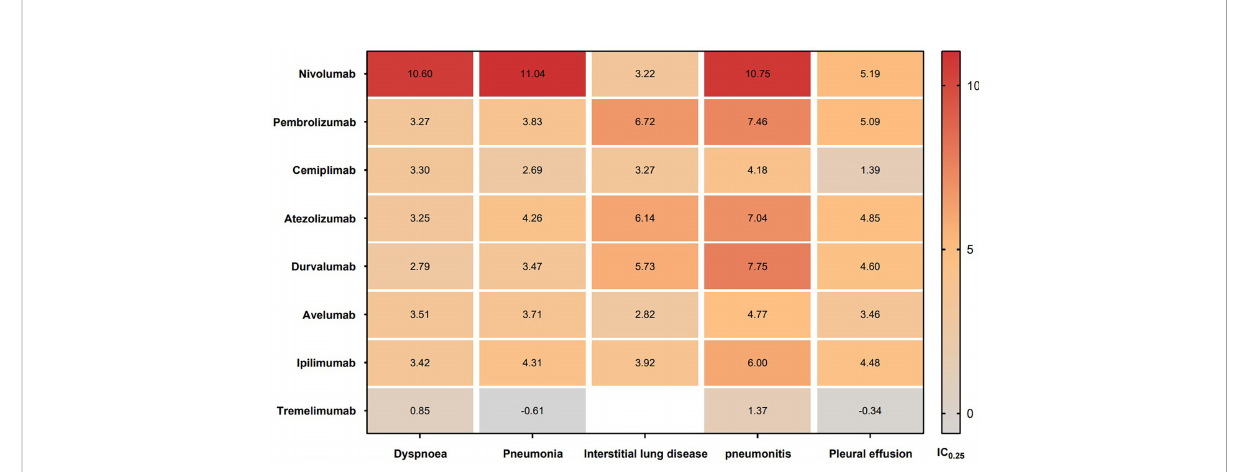
FIGURE 5 IC 025 values across class-speci fi c ICIs and the top 5 most frequently reported PTs of respiratory system AEs in the FAERS database. ICIs, immune checkpoint inhibitors; AEs, adverse events; IC, information